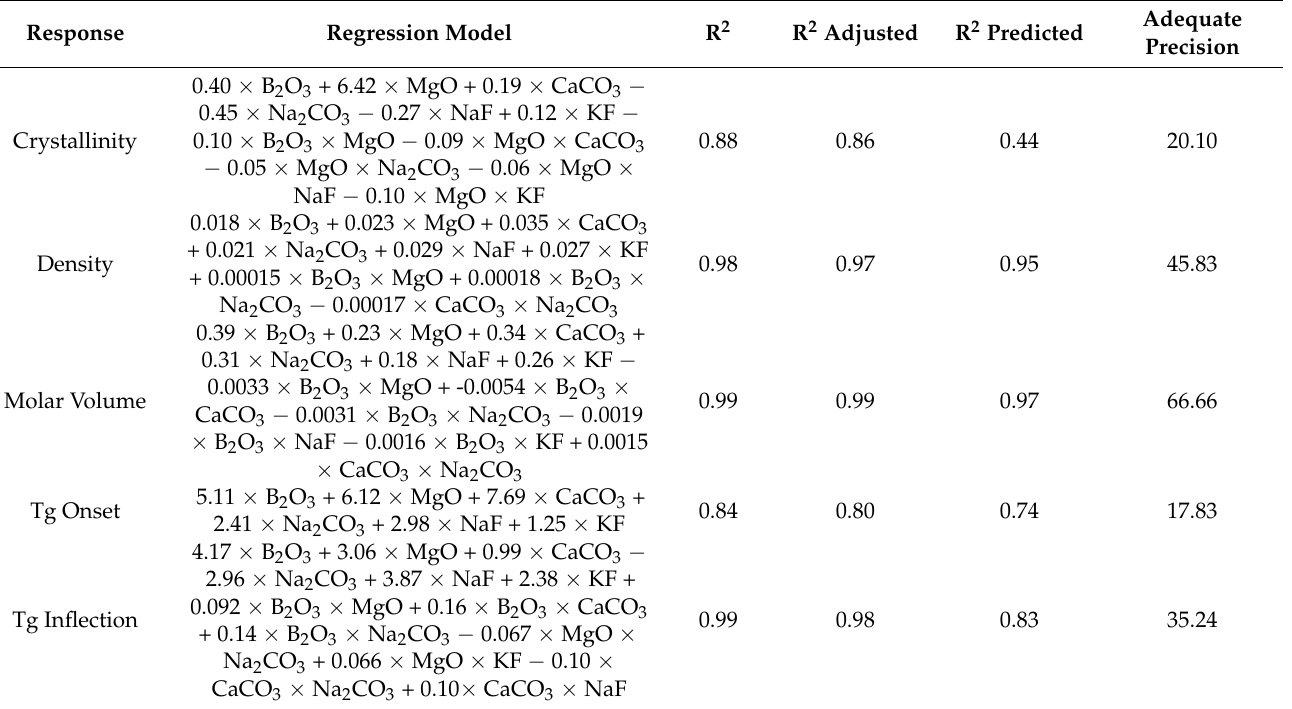
Figure 1. Representative XRD spectrum collected from ground powder from quenched glass of ( a ) composition 9 and ( b ) composition 10. Table 4. Regression model equations (actual equations) generated through design expert for the prediction of glass properties, along with the model fit